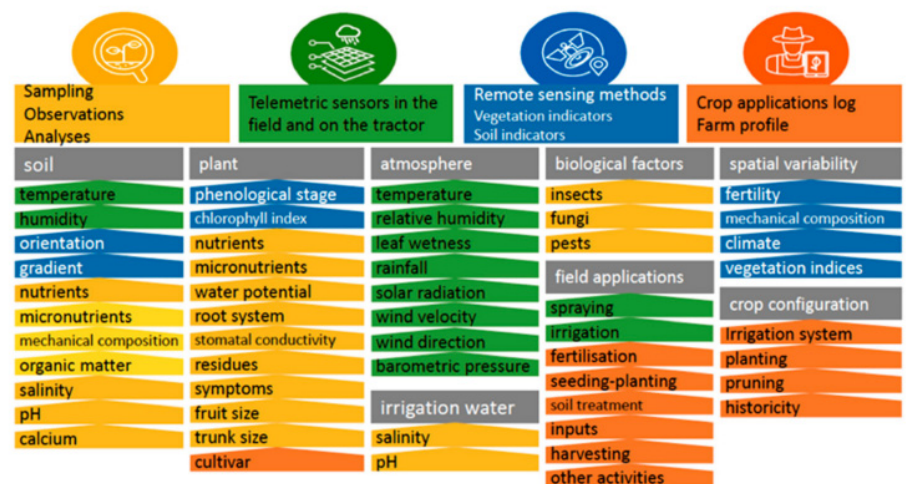
Figure 3. Information sources and data utilized in SmartPeach project.